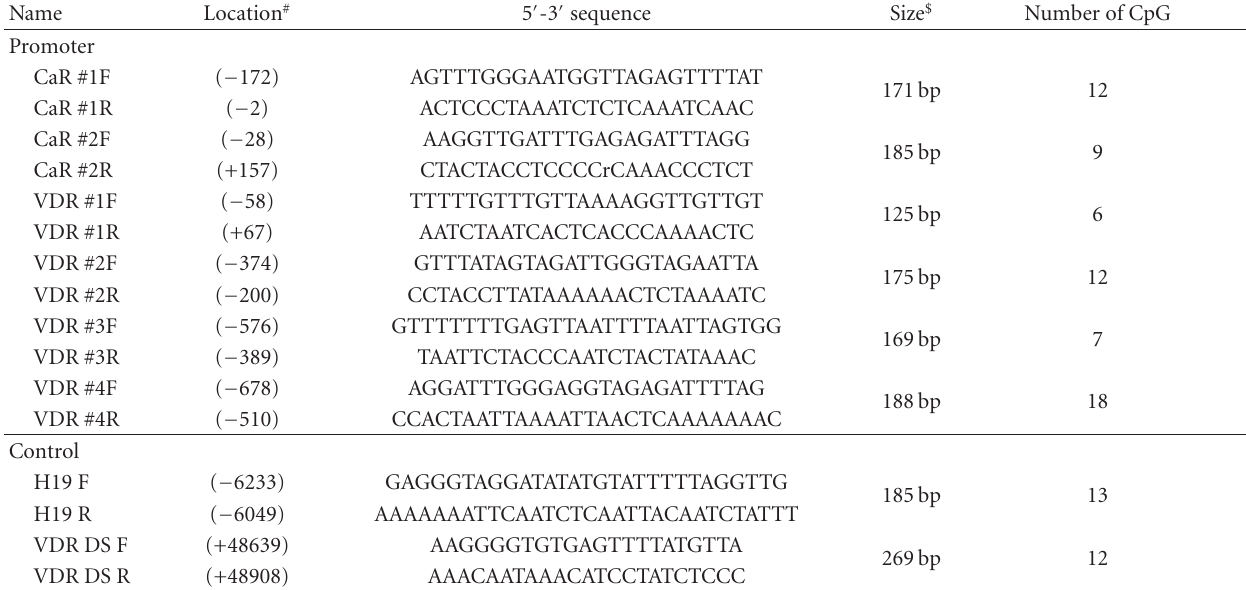
Table 1: PCR primers used for methylation detection by melting temperature profiling.